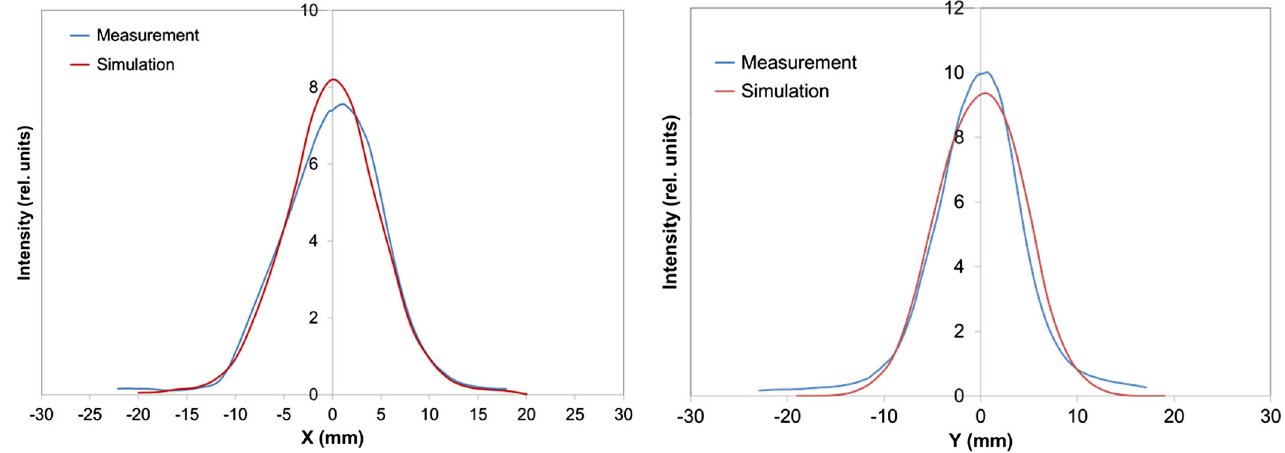
FIG. 18. Measured and simulated beam profiles at 98 cm downstream of the RFQ.